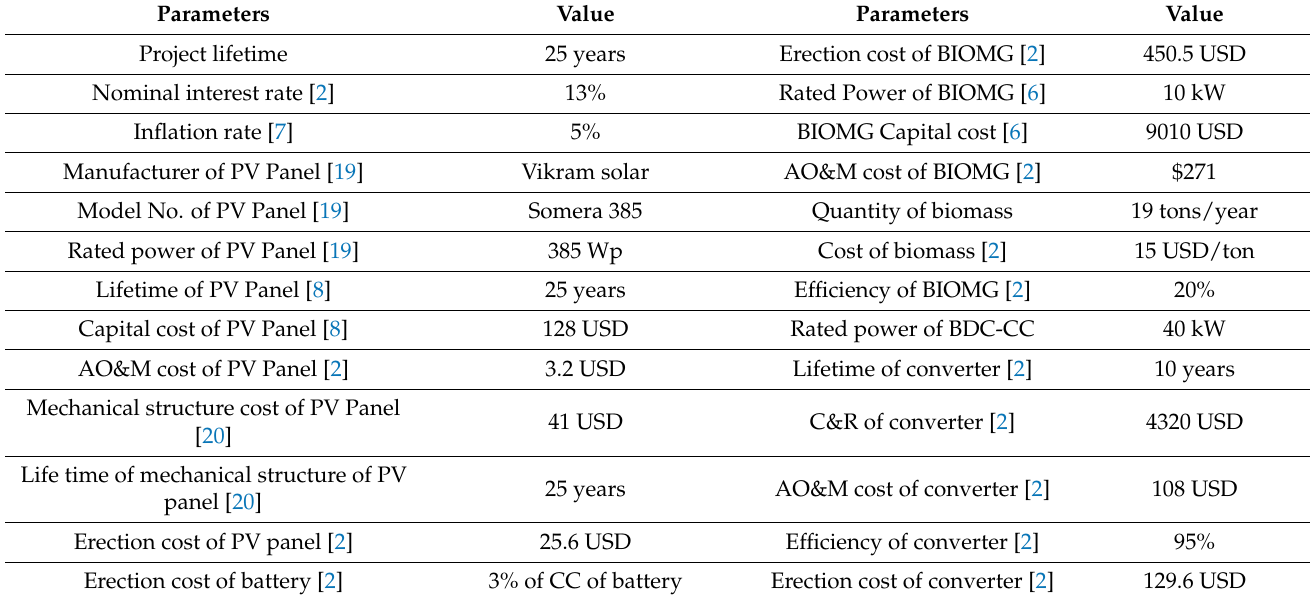
Table 2. The study’s technical and financial values.